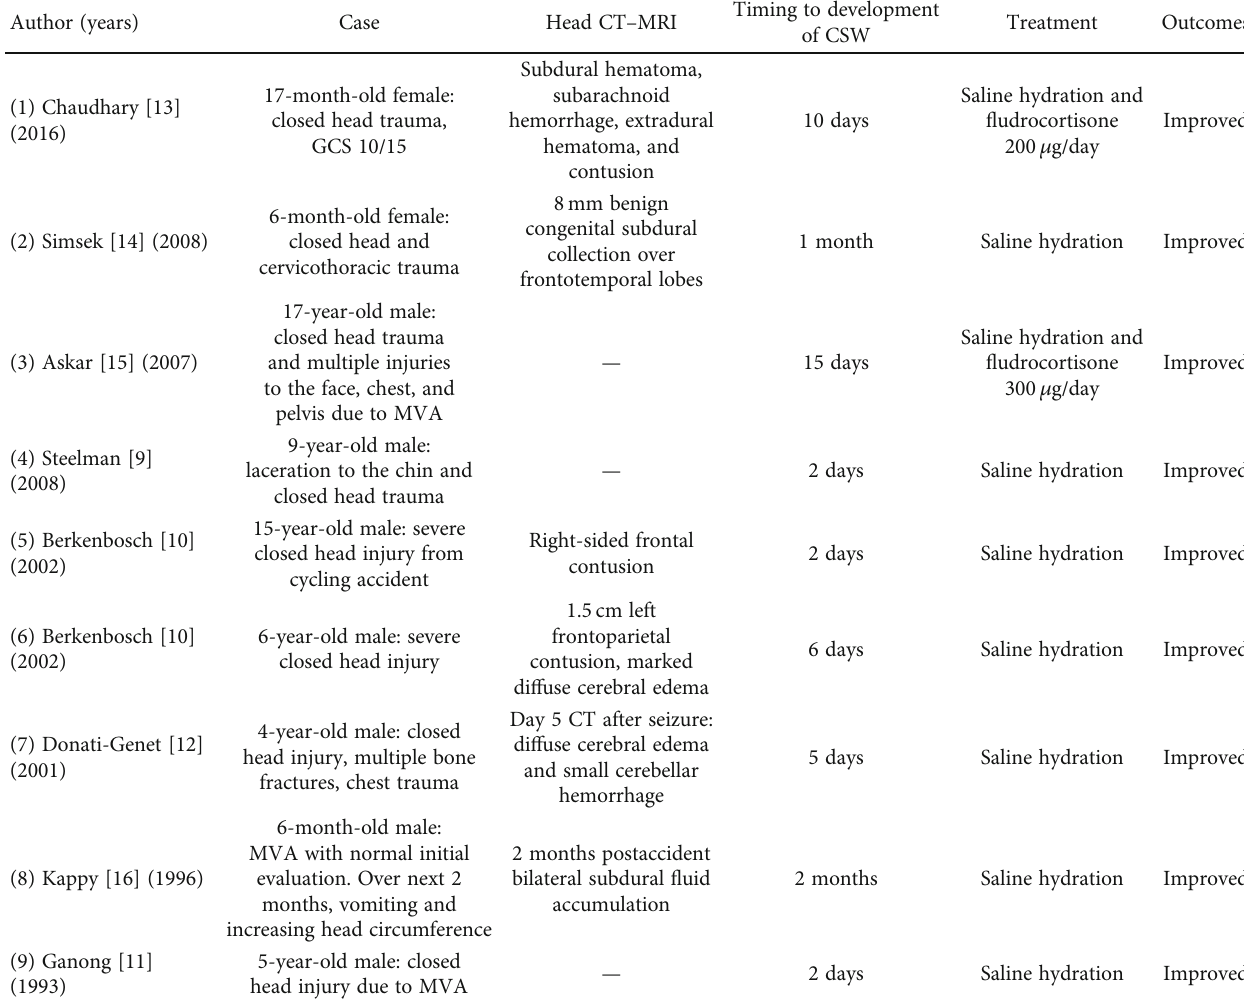
Table 1: Summary of pediatric case reports examining cerebral salt wasting after traumatic brain injury. Author